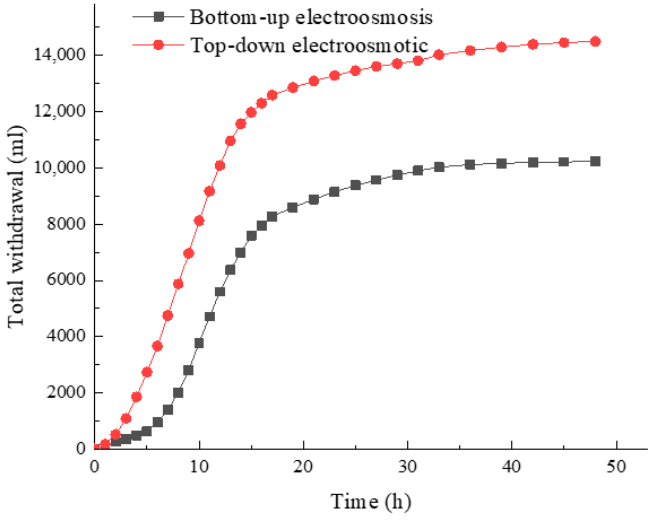
Figure 9. Variation curve of water discharge volume with time in electro-osmosis test. The water discharge rate with time in electro-osmosis tests is shown in Figure 10. The water discharging rate of the top-down electro-osmosis group was greater than that of the bottom-up electro-osmosis group in the early and late stages, and the discharging rate in the middle stage was basically the same. The average discharging rate of the bottom-up electro-osmosis group was 192.14 mL/h, and the average discharging rate of the top-down electro-osmosis group was 280.52 mL/h, with an increase of 46.00%. The reason was that the water in the top-down electro-osmosis group could converge to the lower cathode faster under its own gravity, and the discharging rate was